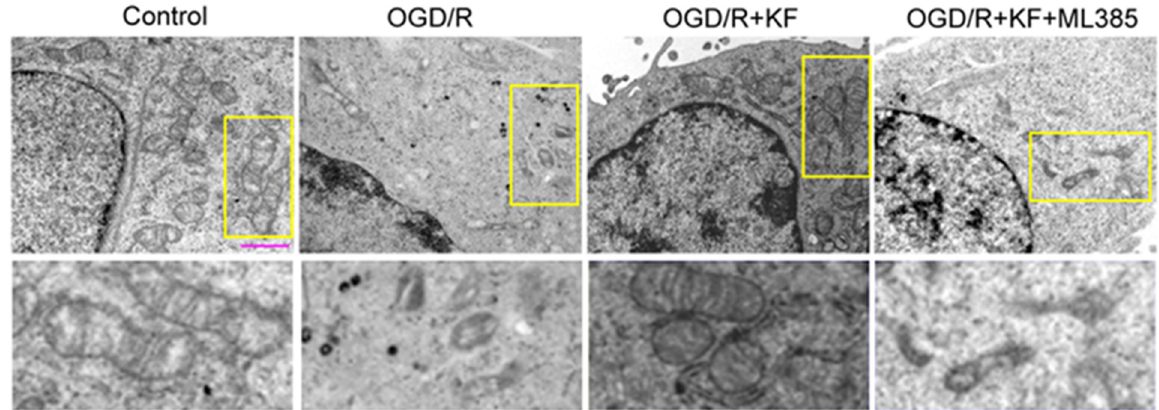
Figure 5. Effect of kaempferol mitochondrial morphology in OGD/R-treated neurons. Neurons were treated as indicated in (Figure 1A). Mitochondrial morphology associated with ferroptosis was determined by transmission electron microscopy. Bottom panels display the magnified images of regions indicated by yellow rectangles in the top panels. Scale bar, 1 µm.